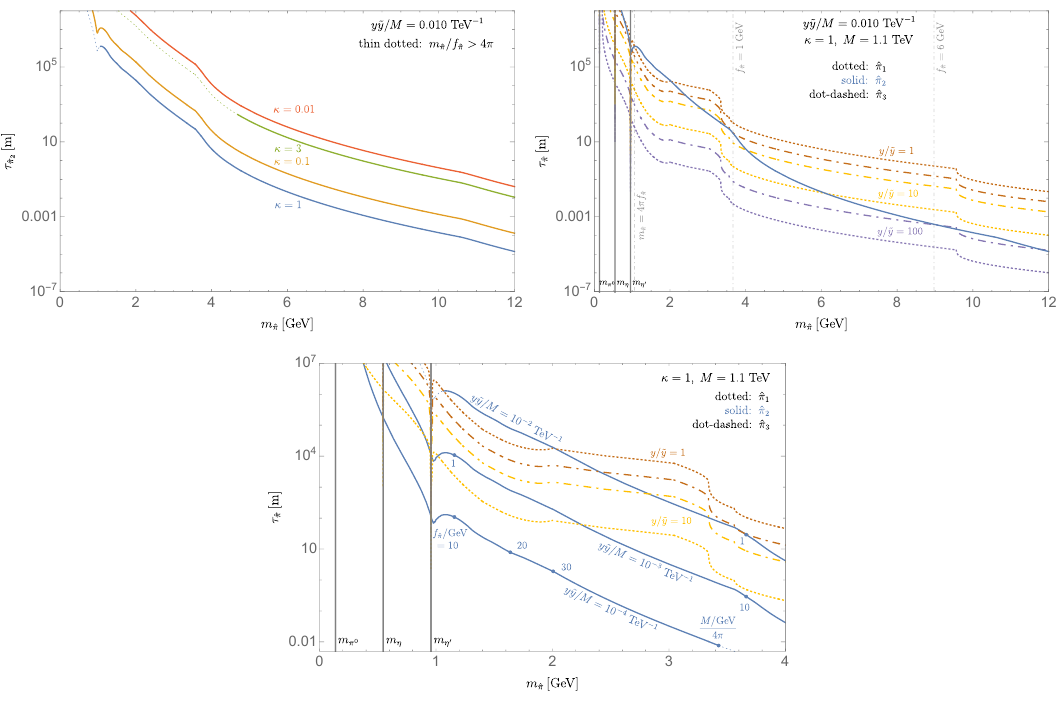
Figure 5 . Lifetimes of the dark pions for a CP -conserving dark sector. (Top left) lifetime of ˆ π 2 for representative values of κ , setting y ˜ y/M to saturate the h → inv bound. Note that for a given m ˆ π , to each curve corresponds a different value of f ˆ π via eq. (4.18); the thin dotted portions have m ˆ π > 4 πf ˆ π and are therefore not physical. (Top right) lifetimes of the three dark pions for κ = 1 , M saturating the constraint from direct Q searches, y ˜ y/M saturating the h → inv bound, and illustrative choices of y/ ˜ y consistent with the Z → inv bound. (Bottom) zooming in on light dark pions with m . 2 m and showing the effect of decreasing y ˜ y/M . Due to a compensating increase ˆ π c,τ of f via eq. (4.18), the ˆ π lifetimes are not affected, whereas the one of ˆ π ˆ π 1 , 3 mark representative values of f in ˆ π